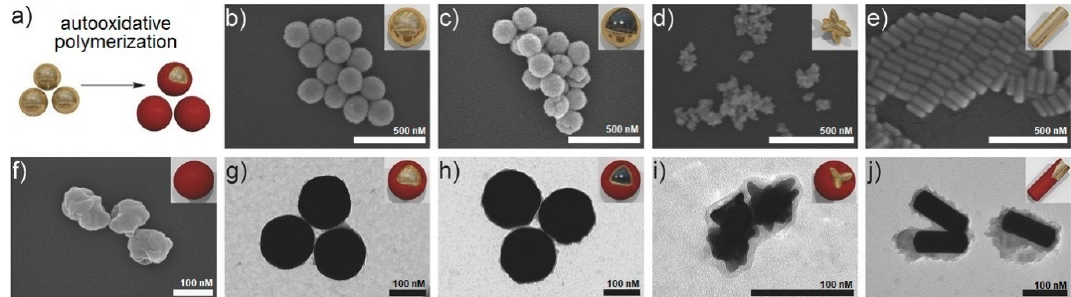
Figure 8. Synthesis of melanin-coated gold particles. ( a ) Auto-oxidation of dopamine to melanin can be conducted as a seeded dispersion polymerization to deliver gold-core melanin-shell particles. ( b – f ) Scanning electron micrographs (SEM) of pristine and melanin-coated gold nanoparticles: ( b ) spherical gold particles (Au), ( c ) spherical silica-core gold-shell particles (SiAu), ( d ) gold nanostars (AuStars), and ( e ) gold nanorods (AuRods). In ( b – e ), the scale bars represent 500 nm. ( f ) SEM image of melanin particles without a gold core. ( g – j ) TEM images of melanin-coated ( g ) spherical gold nanoparticles (AuMel), ( h ) silica-core gold-shell particles (SiAuMel), ( i ) gold nanostars (AuStarsMel), and ( j ) gold nanorods (AuRodsMel). In ( f – j ), the scale bars represent 100 nm. The insets display an artistic rendering of the individual particle geometries. Reproduced with permission from [71].